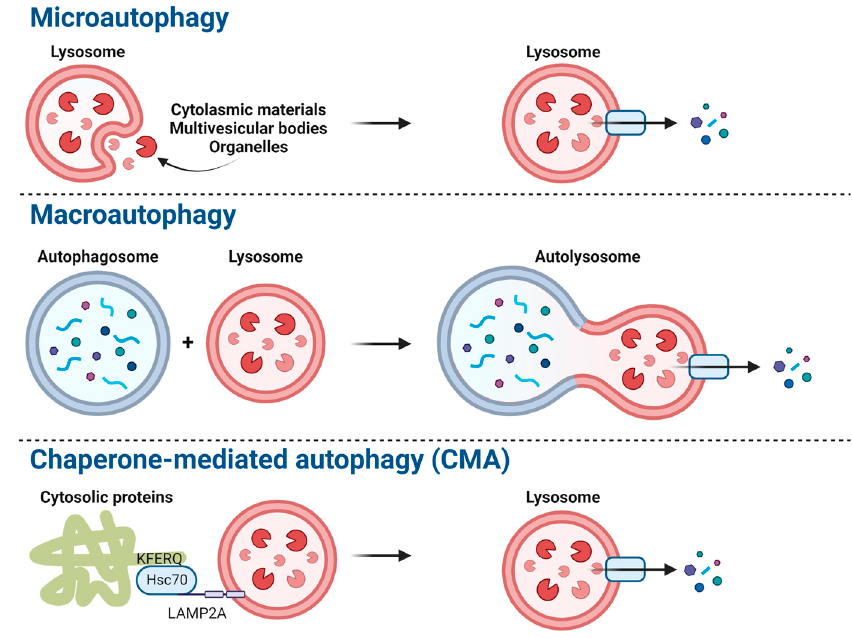
Figure 1. The major autophagic pathways include microautophagy, macroautophagy, and chaperone-mediated autophagy (CMA). This figure was created with biorender.com and accessed on 26 November 2022.